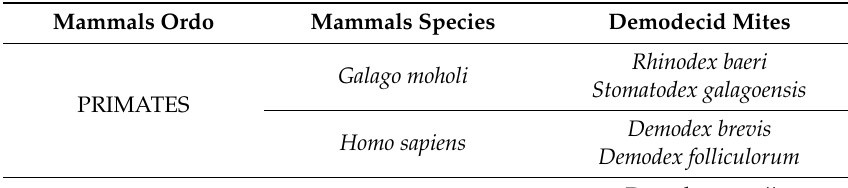
Table 3. Synhospital (co-occurring) demodecid mites in the same host